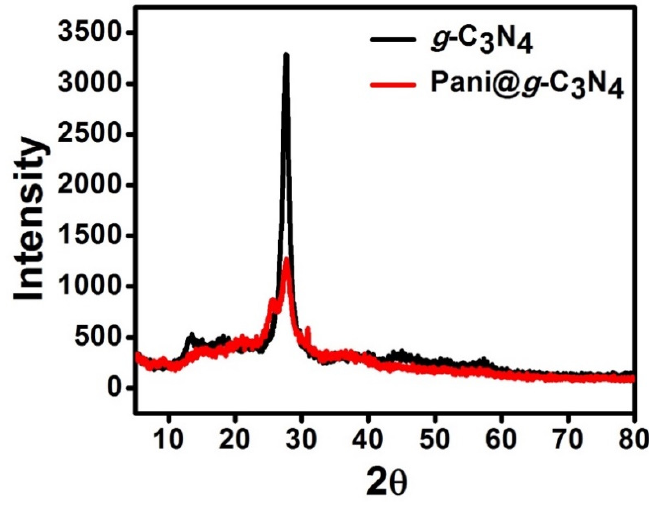
Figure 3. XRD pattern of g-C 3 N 4 and Pani@g-C 3 N 4 .